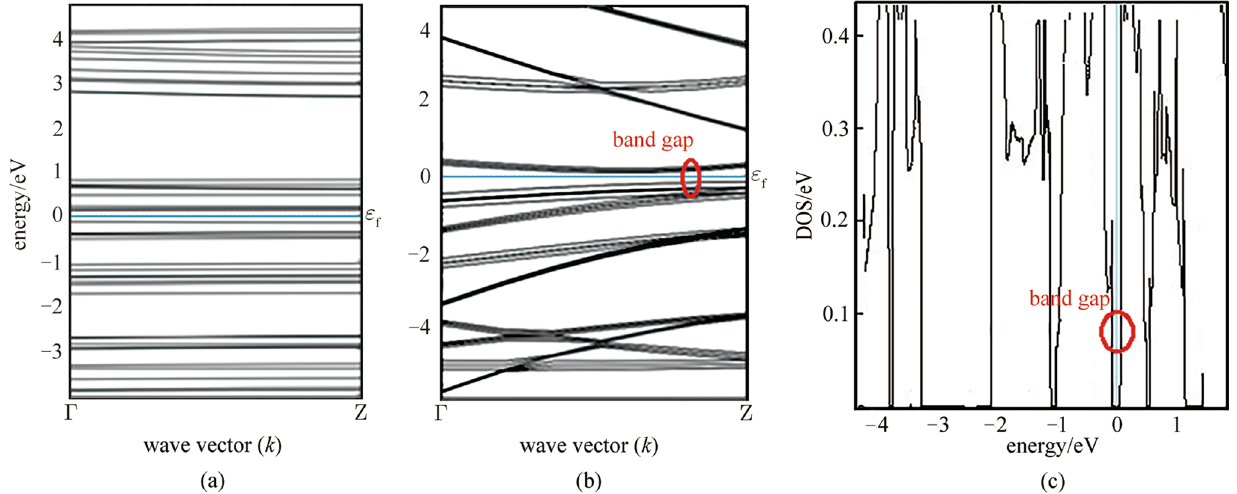
Fig. 5 Band structure in k space along wave vector for the graphene/Si QDs SL; a with an 8 nm inter-dot spacing; b for closely packed SL; c density of states for closely packed graphene/Si QDs